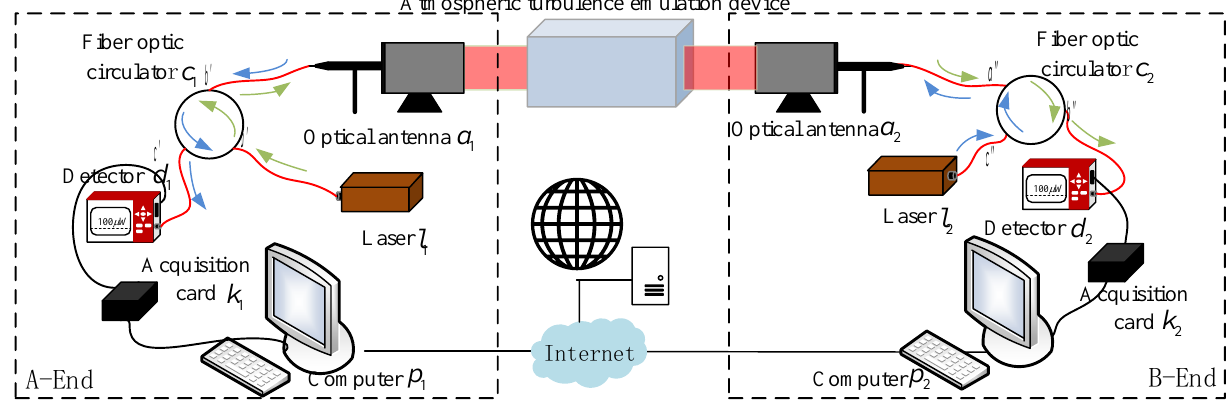
Figure 4. Indoor bidirectional transceiving coaxial atmospheric laser propagation system.